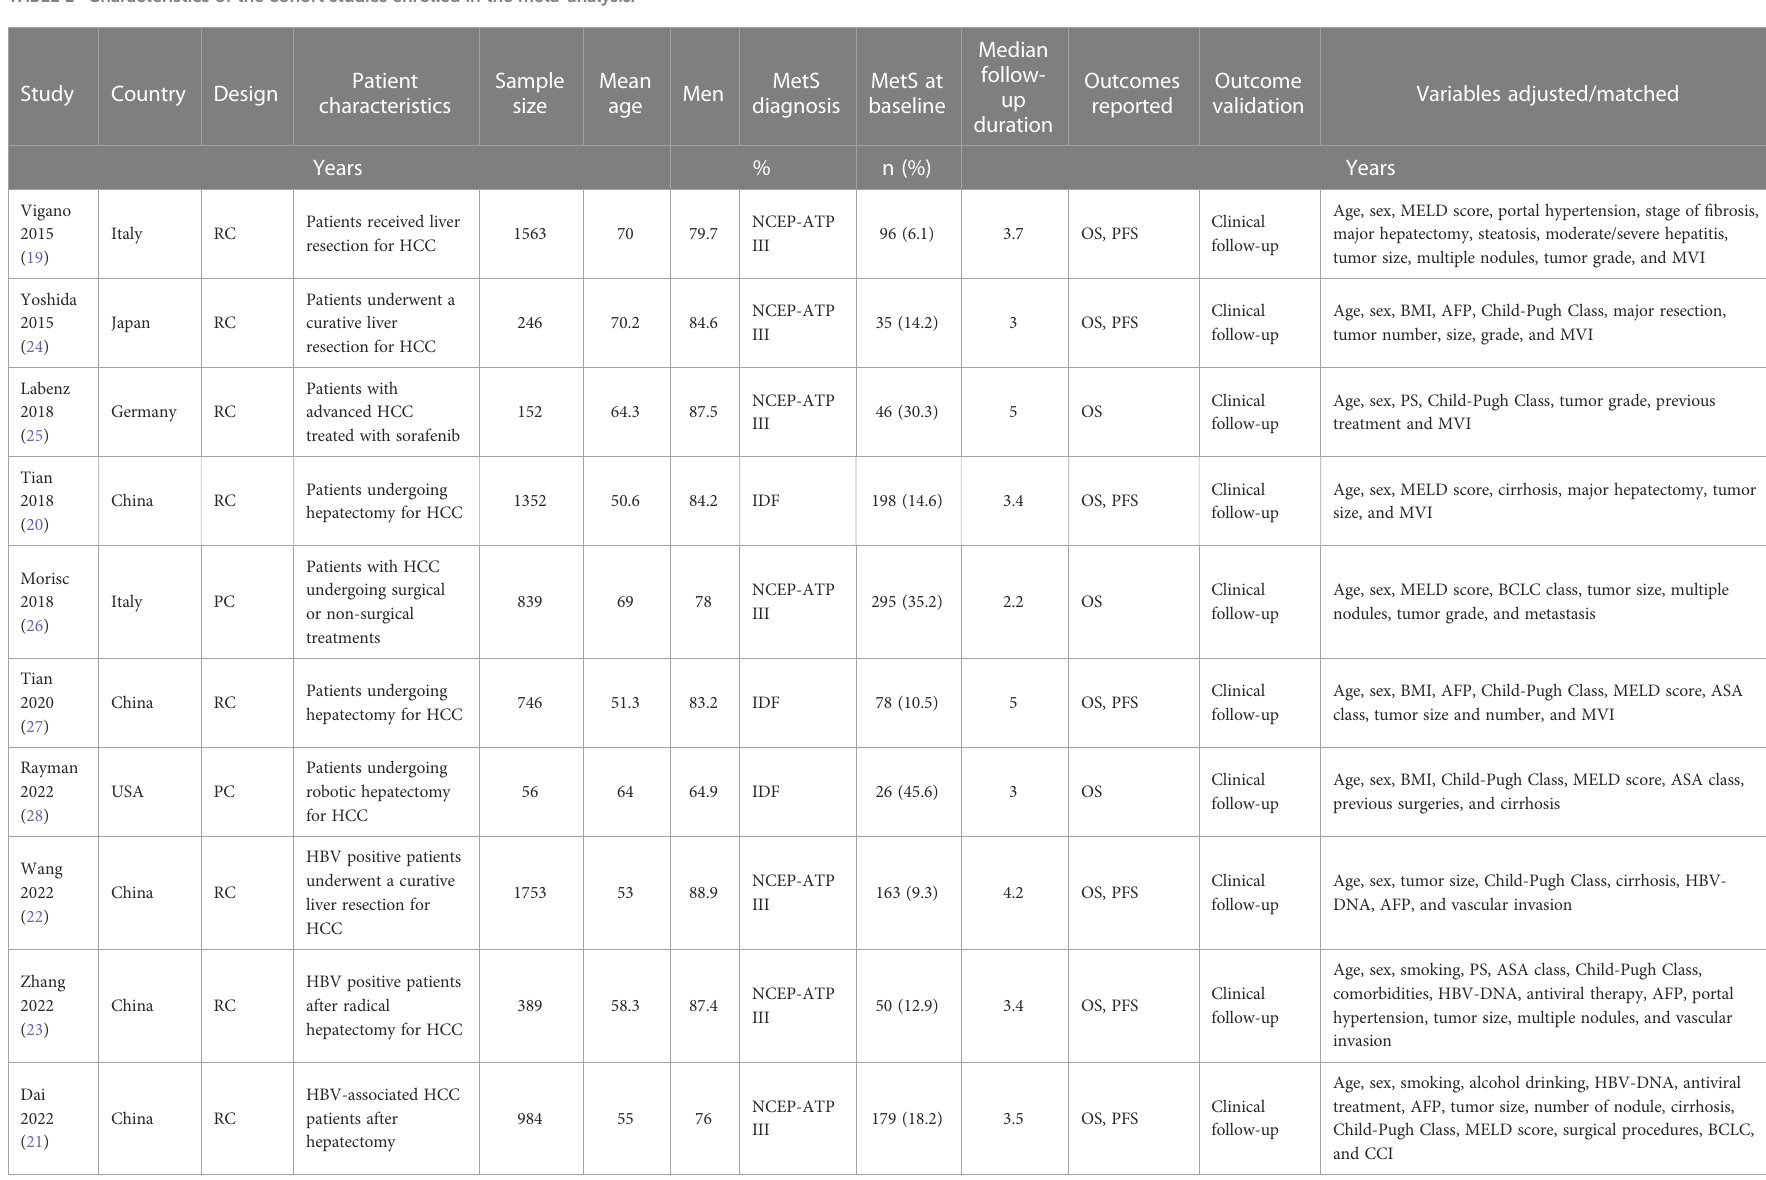
TABLE 1 Characteristics of the cohort studies enrolled in the meta-analysis.